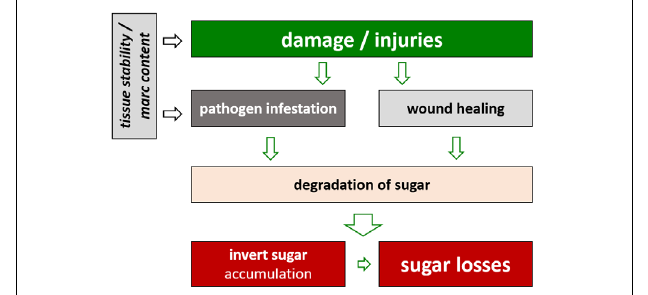
FIGURE 2 | Effect of damages of sugar beet roots on sugar losses during